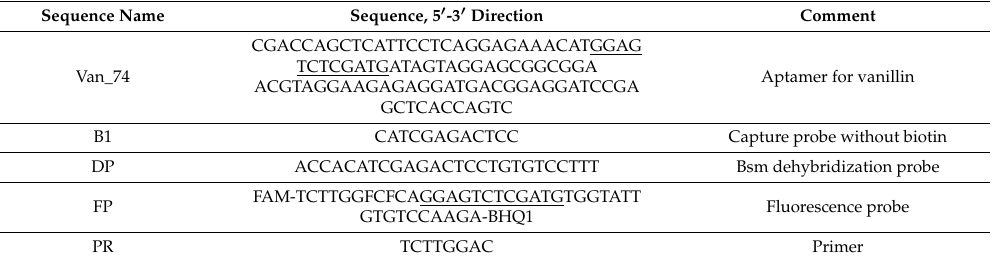
Table 1. Oligonucleotide sequences used in Bsm DNA polymerase reaction. The underlined sequence is a capture sequence.